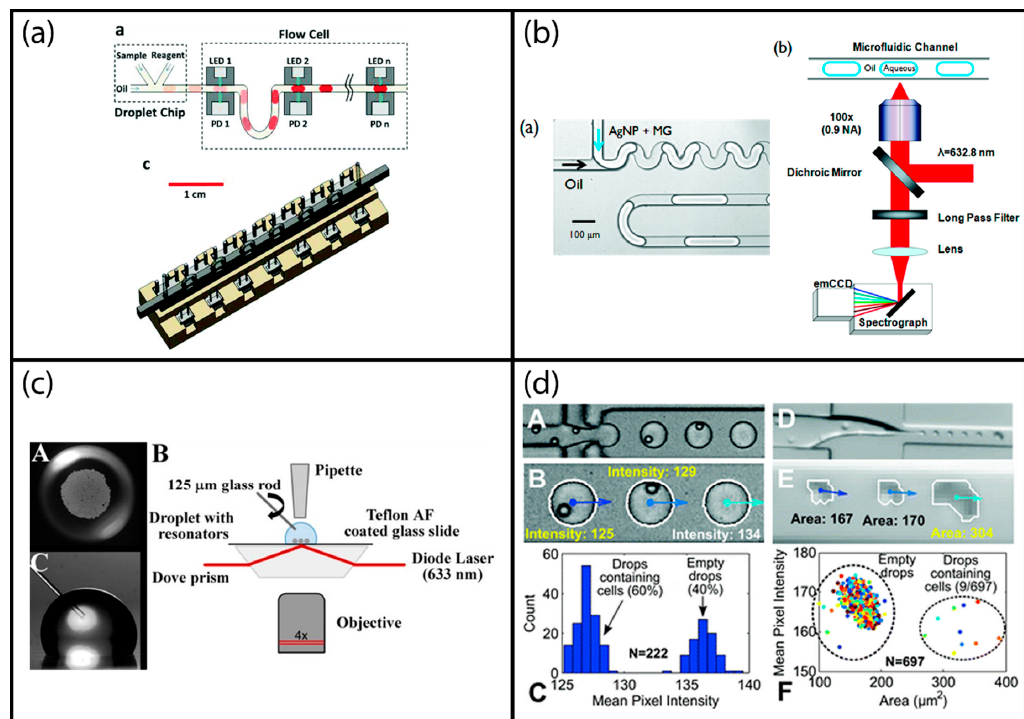
Figure 4. Examples of label-free optical droplet detection: ( a ) Multi-point optical absorption measurement of droplets moving inside a tubing; reproduced from [38] with permission of The Royal Society of Chemistry. ( b ) Surface enhanced resonance Raman spectroscopy (SERSS) detection adapted to segmented flow droplets using silver nanoparticles; adapted with permission from [53]. Copyright 2011 American Chemical Society. ( c ) Evanescent field sensing using whispering gallery mode resonance sensors; reprinted under Creative Commons Attribution License 4.0 from [20]. ( d ) Image processing-based sensing of segmented droplets; reproduced from [62] with permission of The Royal Society of